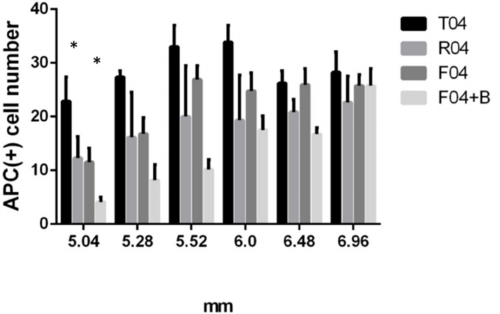
Figure 15. APC+ cells in the dorsal funiculus. Statistical analysis for the four groups: T4 = transected, R4 = PNS graft + FGF-1, F4 = transected+ FGF-1, F4 + B = transected + FGF-1+ PD173074. At distances ranging from 5.04 mm from the trauma center, R4 and F4 rats showed lower APC+ cells compared to T4 rats, while F4+ blocker further decrease the number. Statistical significance was evaluated using one-way ANOVA and Tukey’s test *: p < 0.05. Data are presented as mean ± SEM Animal number used: T4 ( n = 4) R4 ( n = 3) F4 ( n = 8) F4 + B ( n = 4).